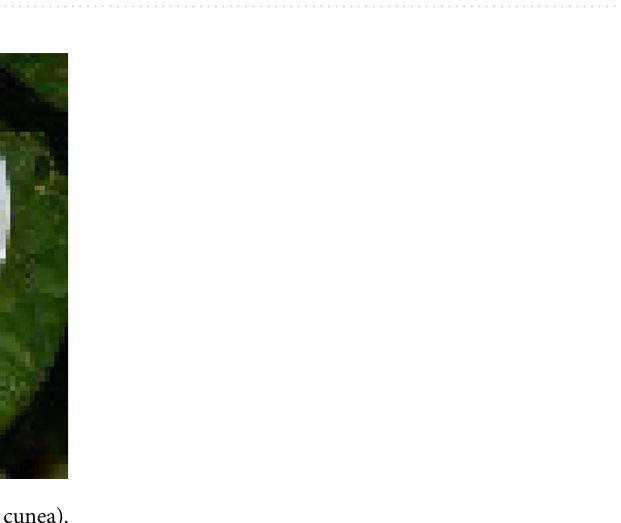
Figure 11. Average loss curves of training phase.